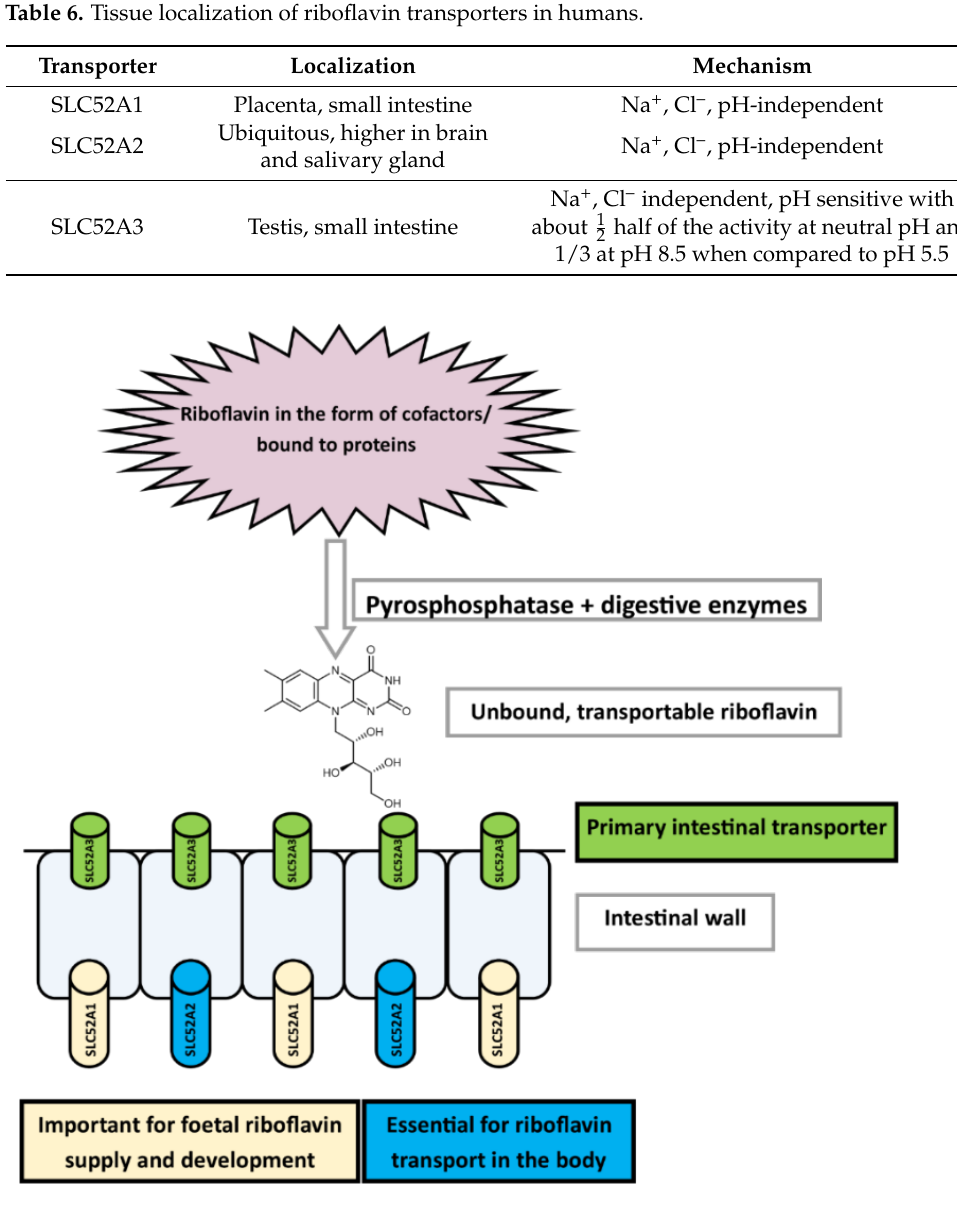
Figure 7. Riboflavin absorption. The majority of riboflavin uptake in the intestine is enabled by SLC52A3, while the other 2 transporters are mainly responsible for basolateral transport to the blood and transport in other cells.